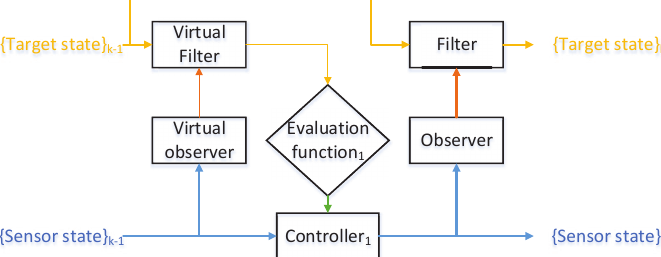
Figure 1. A general diagram of the sensor control process. (yellow lines represent the data flow of targets’ states; blue lines represent sensors’ states; red lines are the observations; green lines represent for the decision-making